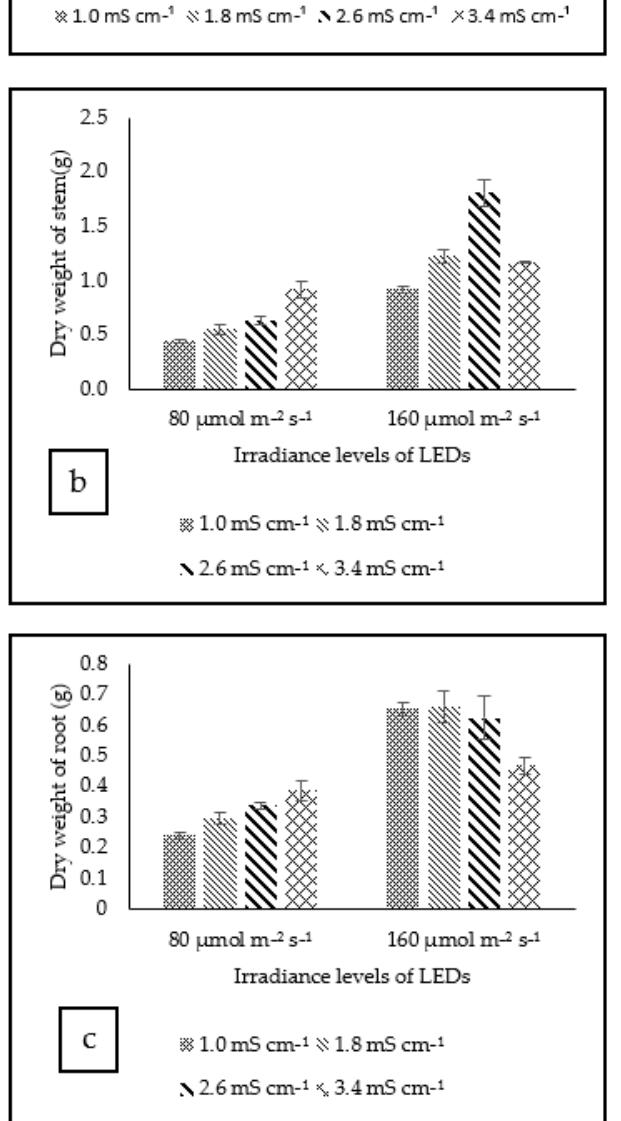
4 Figure 5. Interaction effect of LED irradiance levels and nutrient solution EC on the dry weight of the leaves ( a ), stems ( b ), and roots ( c ) of lemon